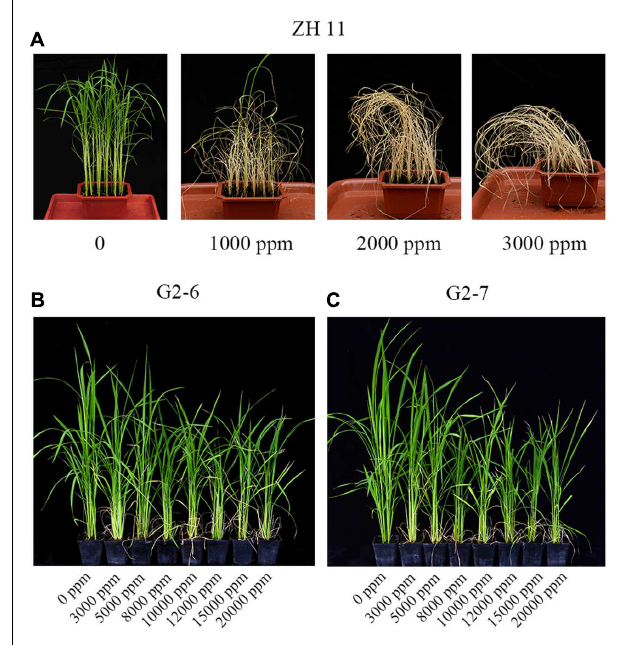
glyphosate treatment. (A) ZH11 grown in the greenhouse for 4 weeks, and photographed 12 days after treatment with 0, 1000, 2000, or 3000 ppm glyphosate. (B,C) transgenic plants G2-6 and G2-7 grown in the